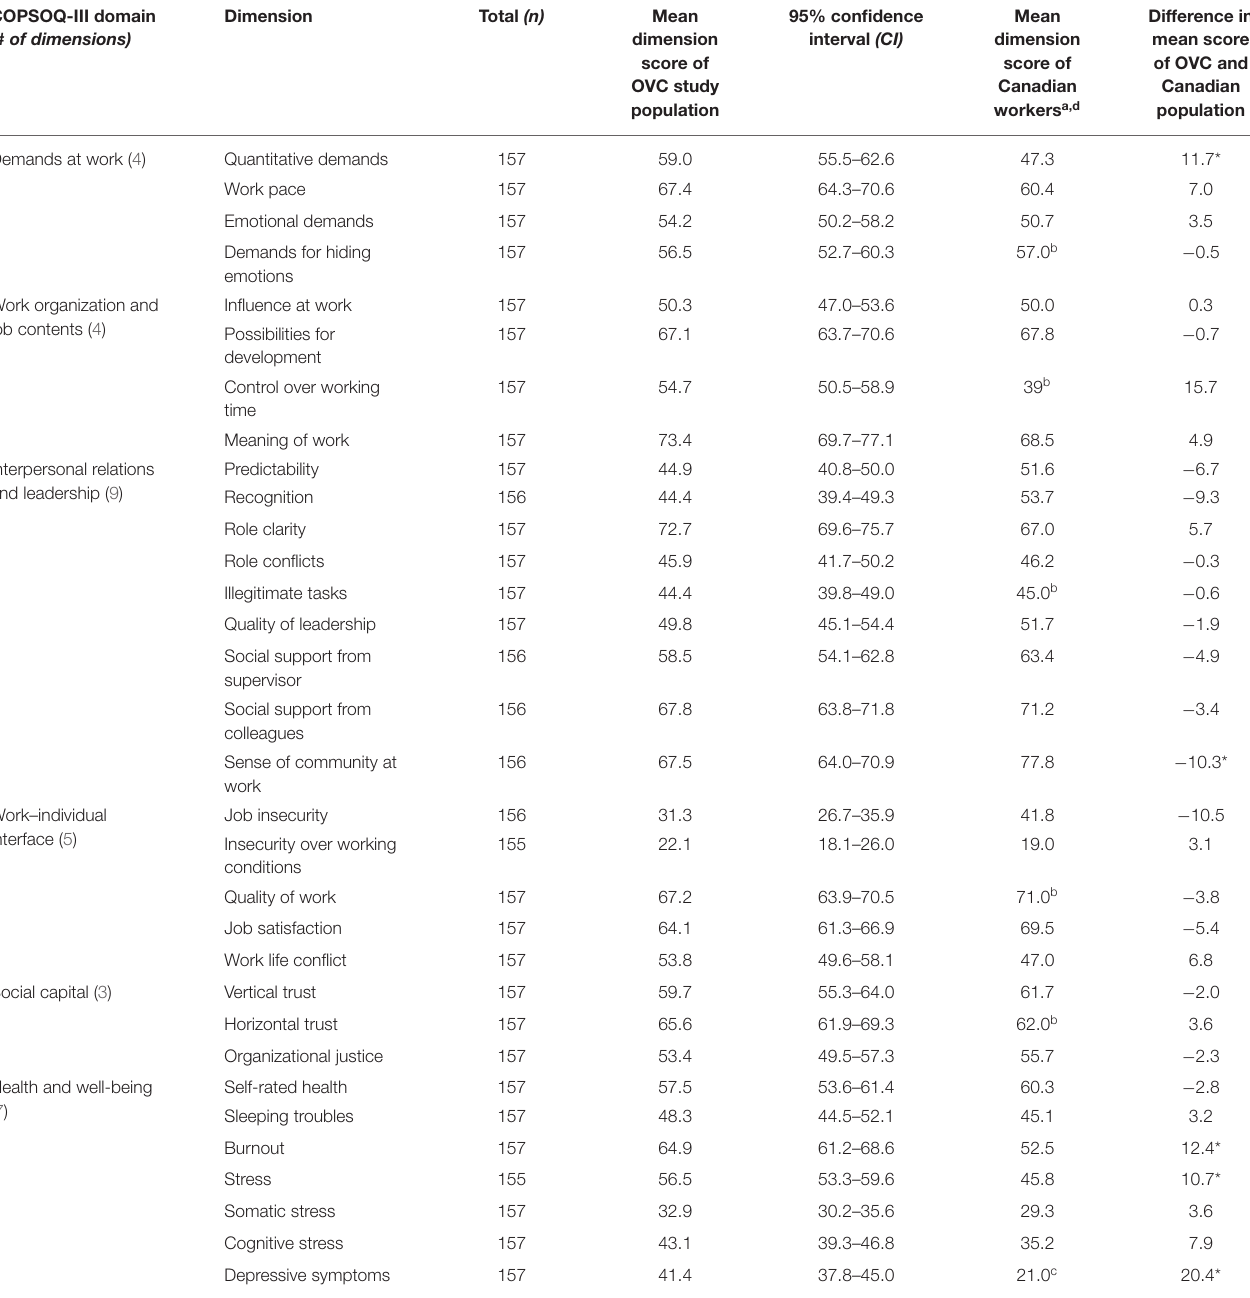
Dimension Total (n) Mean